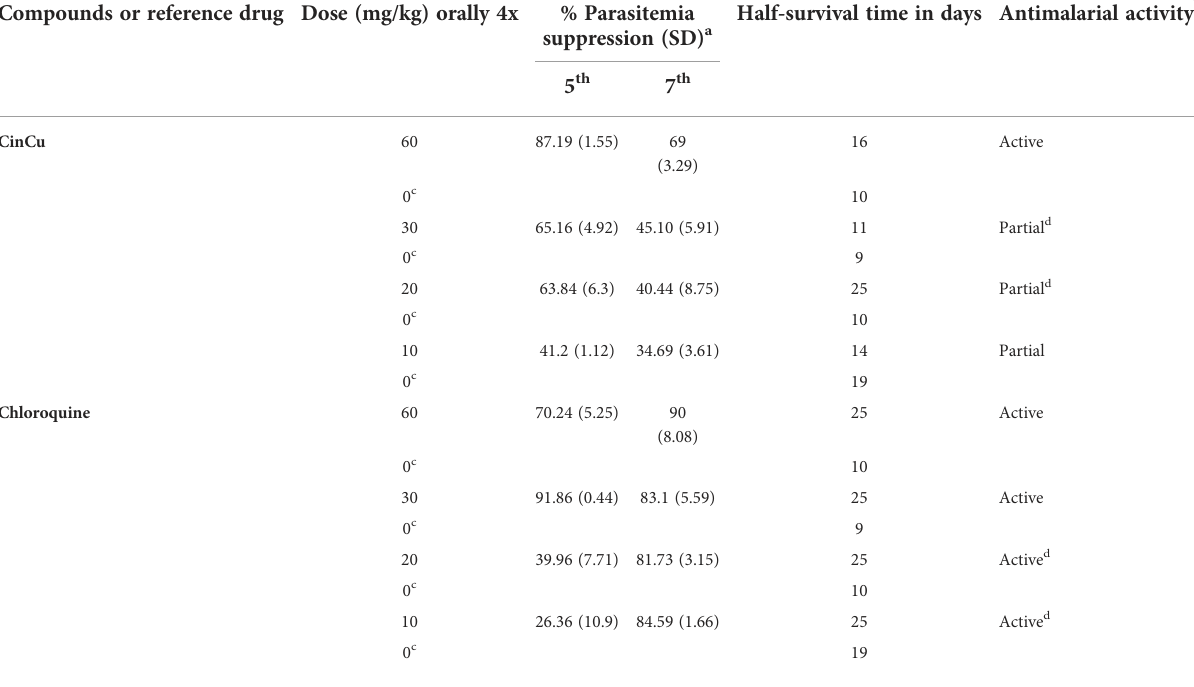
TABLE 2 Antimalarial activity of CinCu and chloroquine in mice infected with Plasmodium berghei ANKA. Compounds or reference drug Dose (mg/kg) orally 4x